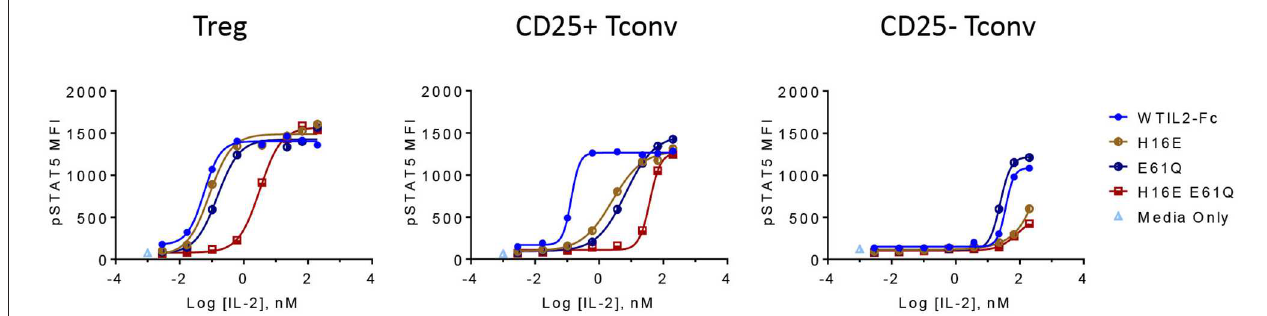
FIGURE 3 | CD25 and IL2RB attenuation synergistically impacts IL-2 mutein activity and selectivity in CD25 + cells. The activity of IL-2 muteins containing a single mutation that slightly reduces affinity to CD25 (E61Q) or to IL2RB (H16E), or both (H16E E61Q), is shown as pSTAT5 MFI at increasing IL-2 mutein concentrations in